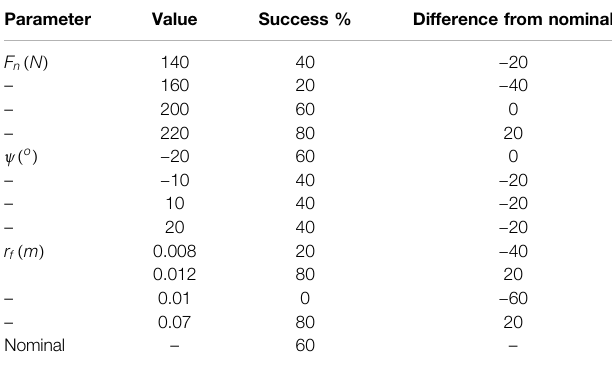
TABLE 2 | Success rates for the sensitivity experiment.